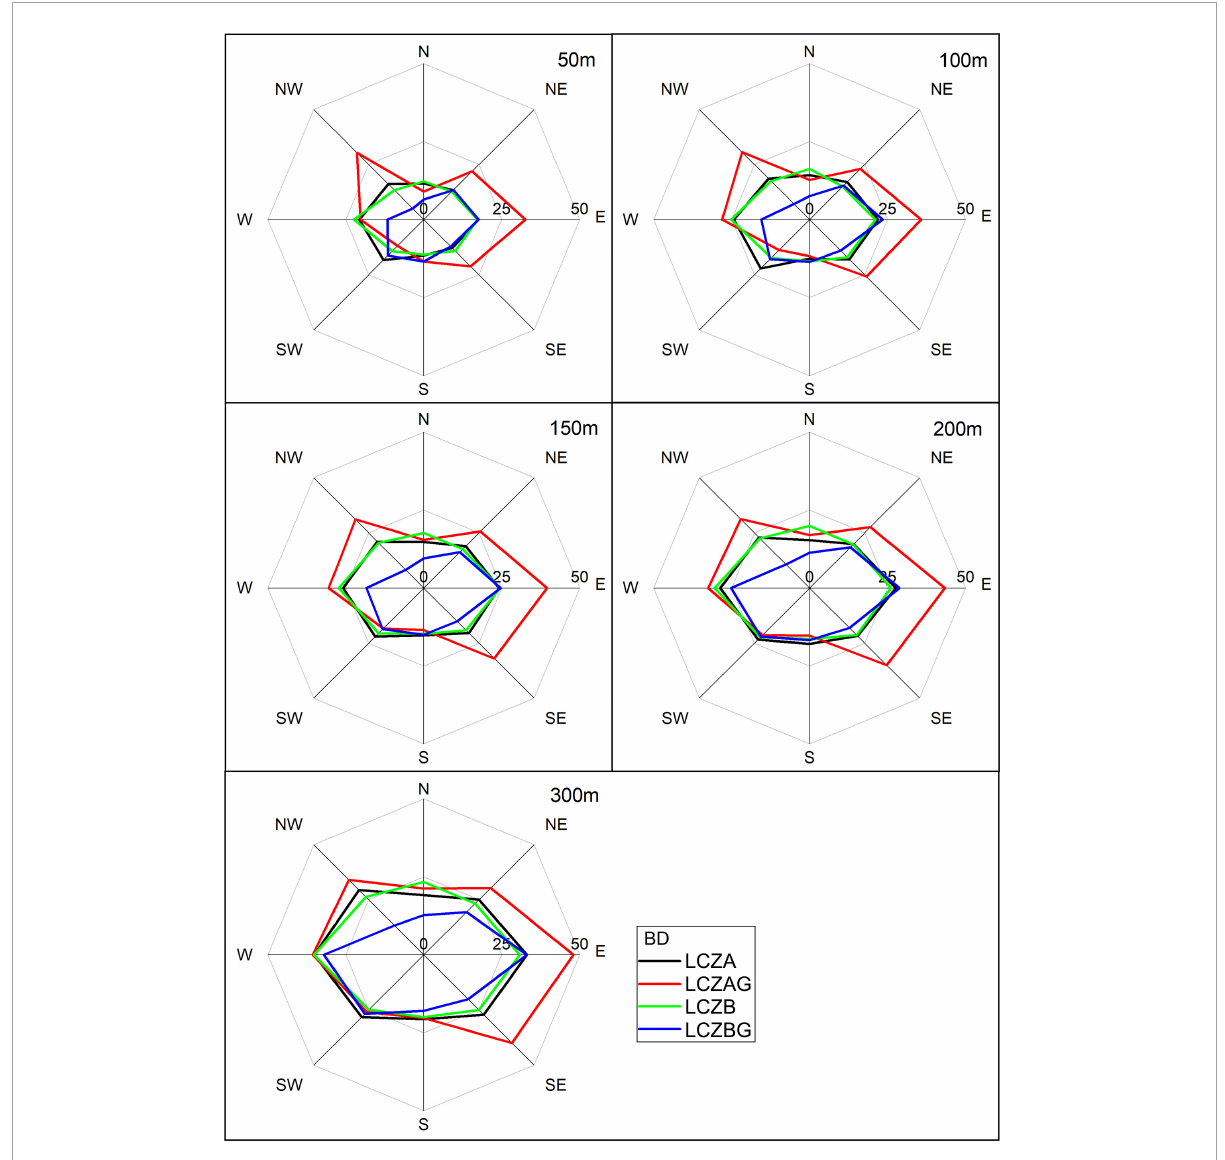
FIGURE10 The BD at eight directions around different urban